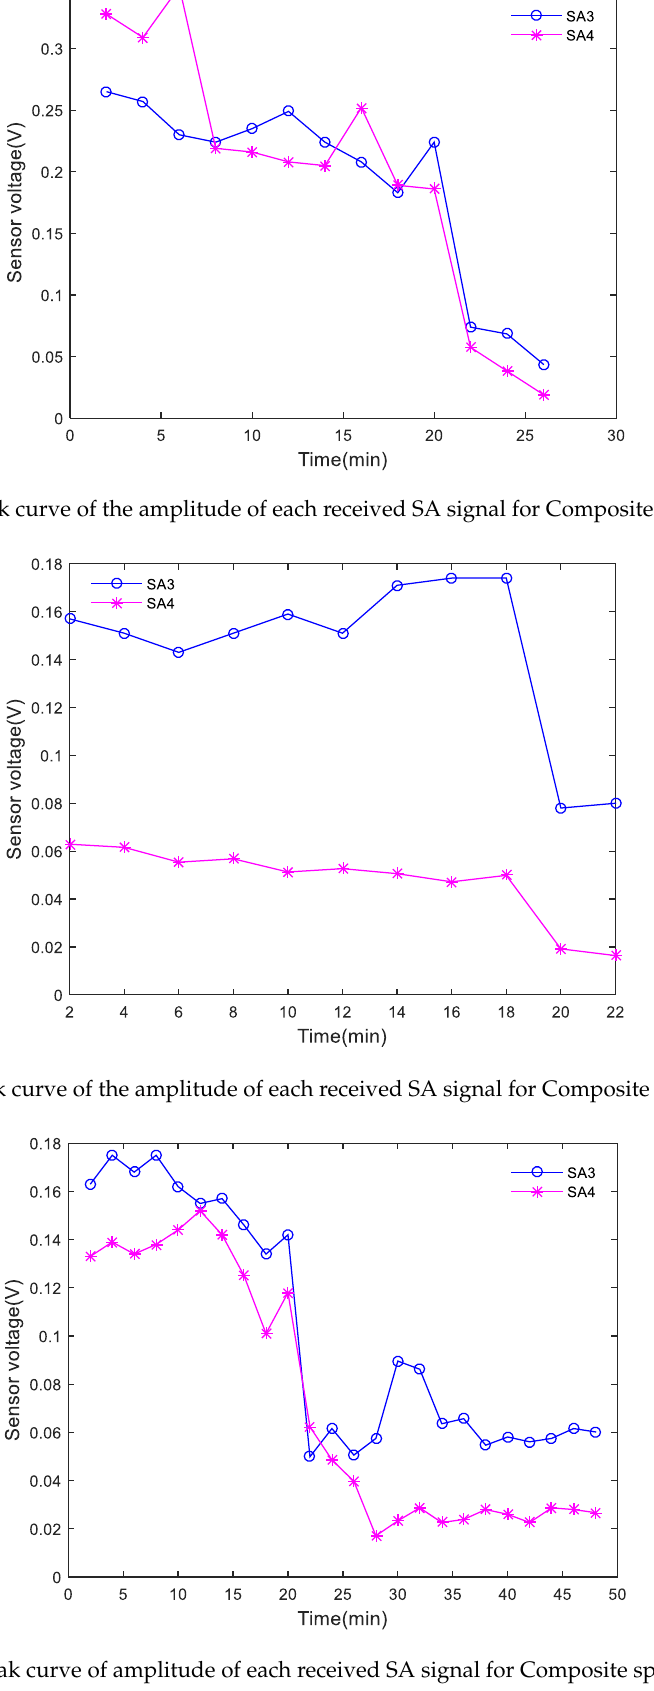
Figure 15. Peak curve of amplitude of each received SA signal for Composite specimen III .